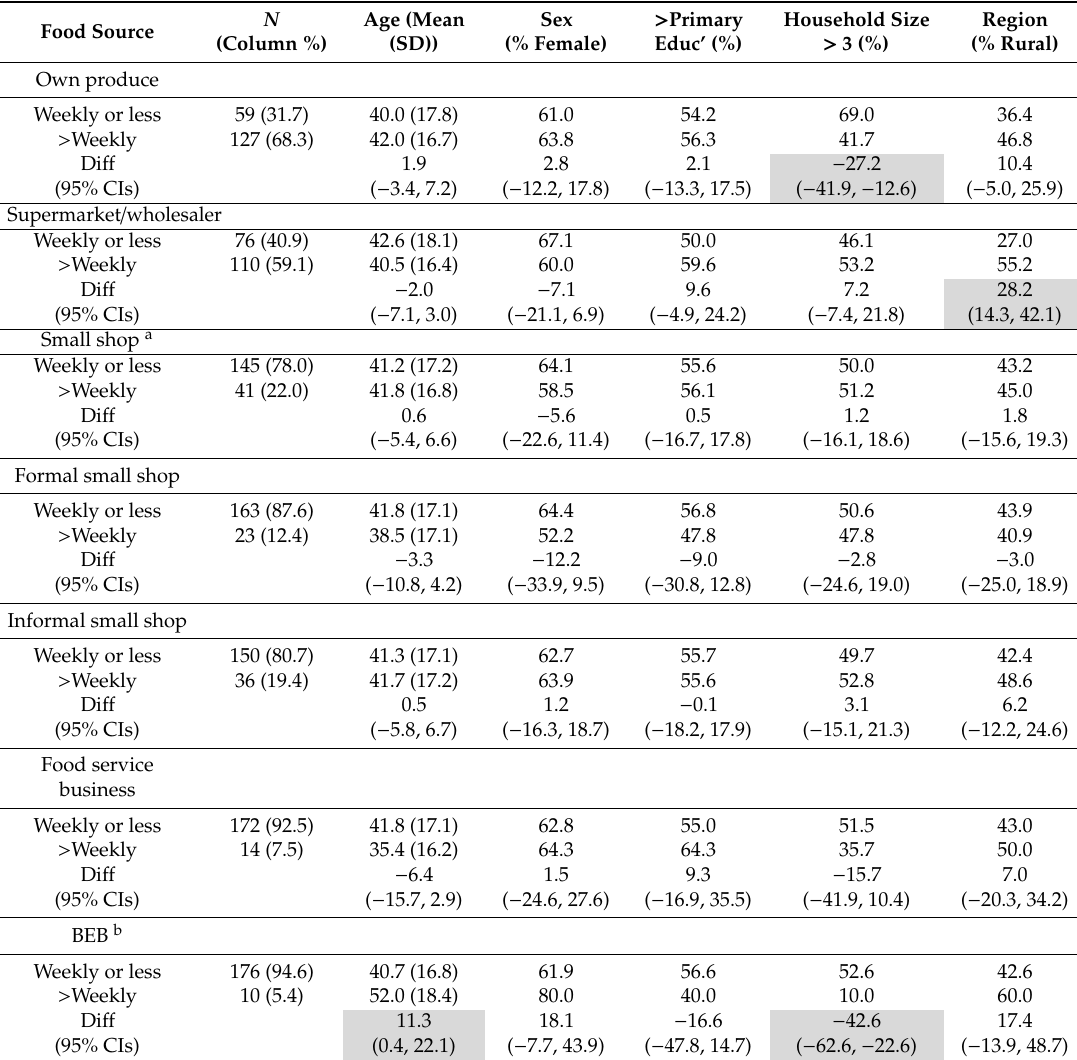
Table 4. Social and demographic characteristics of respondents in the CFaH project by frequency of use of selected food sources in Fiji. *